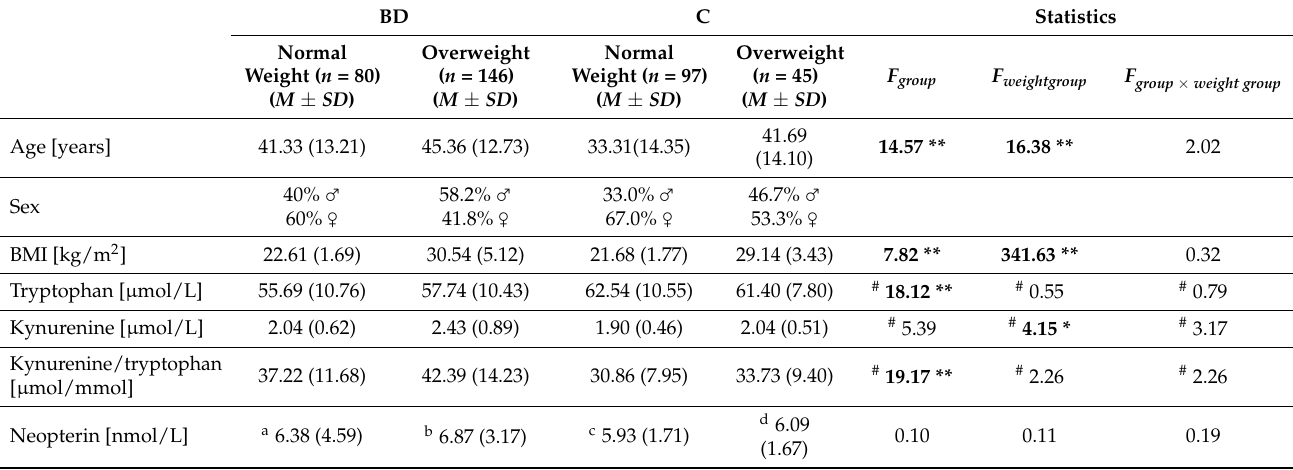
Table 1. Demographic data, tryptophan concentrations, its metabolite kynurenine, and neopterin stratified by weight in BD patients and